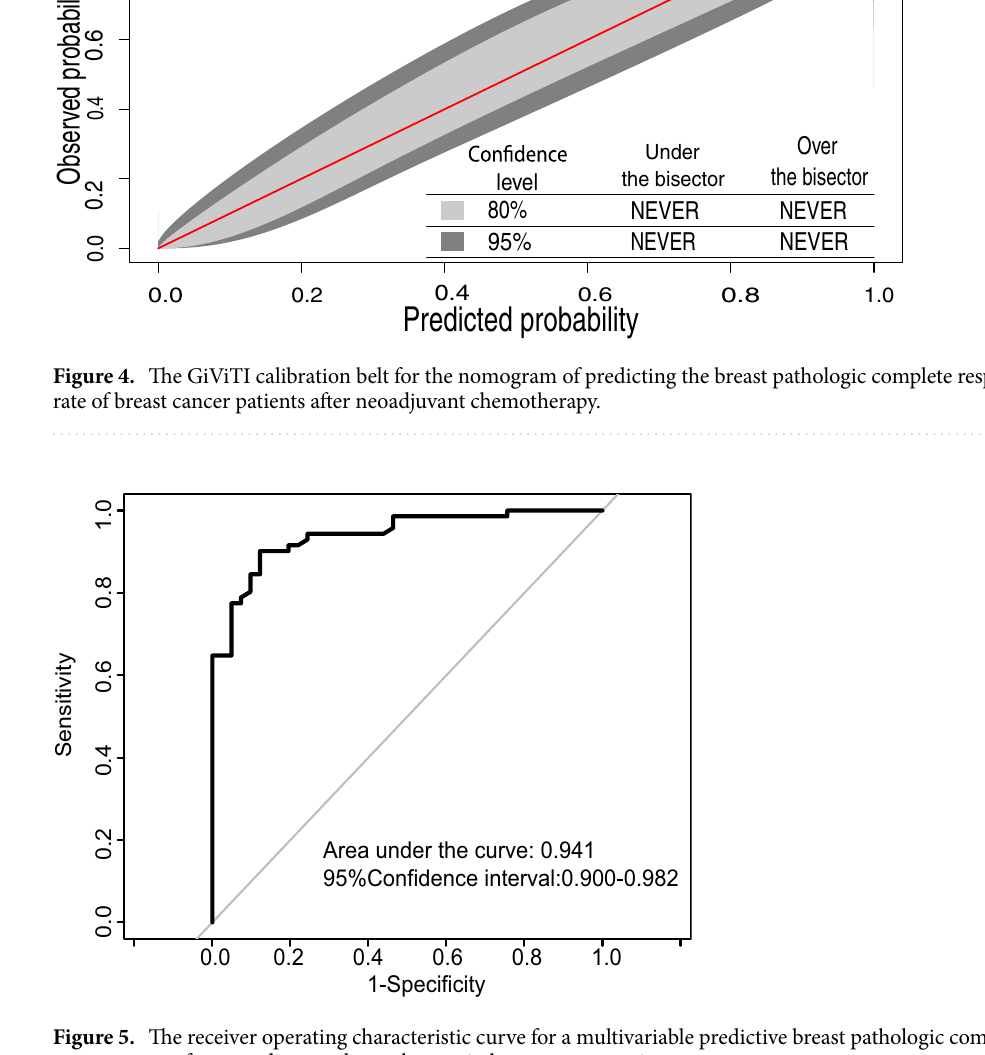
Figure 5. The receiver operating characteristic curve for a multivariable predictive breast pathologic complete response rate after neoadjuvant chemotherapy in breast cancer